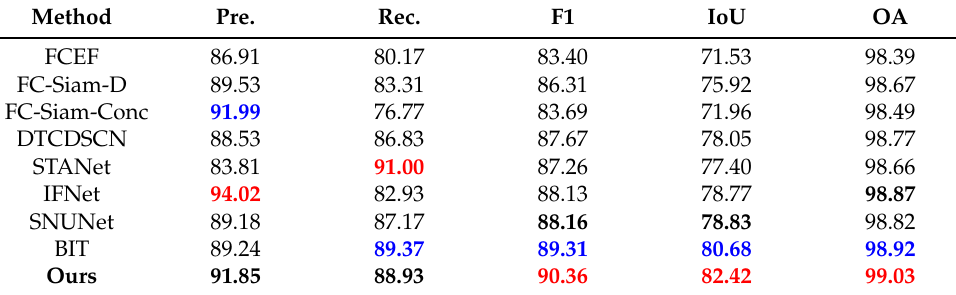
Table 5. The experimental results on the LEVIR-CD test sets